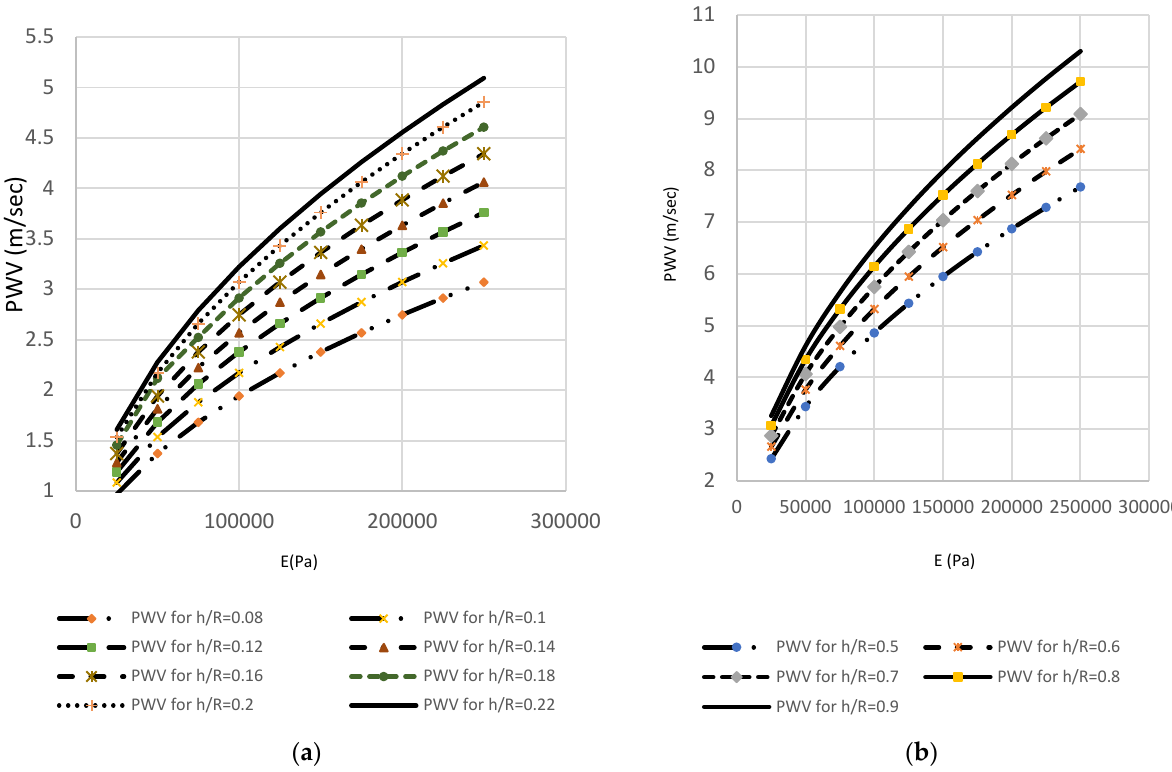
Figure 18. Effects of wall thickness divided by vessel radius in the brachial artery (before and after deformation) on PWV. ( a )The theoretical, i.e., Moens–Korteweg, relationship between the PWV versus artery stiffness (E) for a human brachial artery before deformation; ( b ) the theoretical, i.e., Moens–Korteweg, relationship between the PWV versus artery stiffness (E) for a human brachial artery after deformation due to blood pressure. It is deduced that PWV increases with increased arterial stiffness.